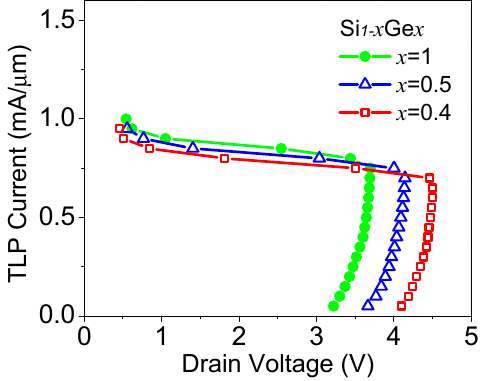
Figure 8. TLP I-V curves of SiGe S/D TFET with different Ge mole fractions.